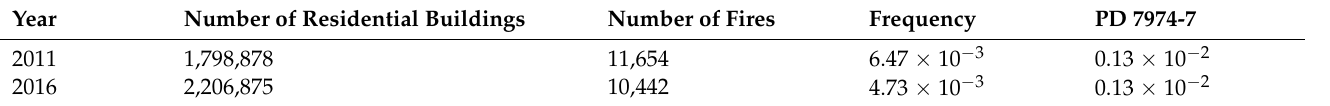
Table 8. Comparison of ignition frequencies with the British standard.